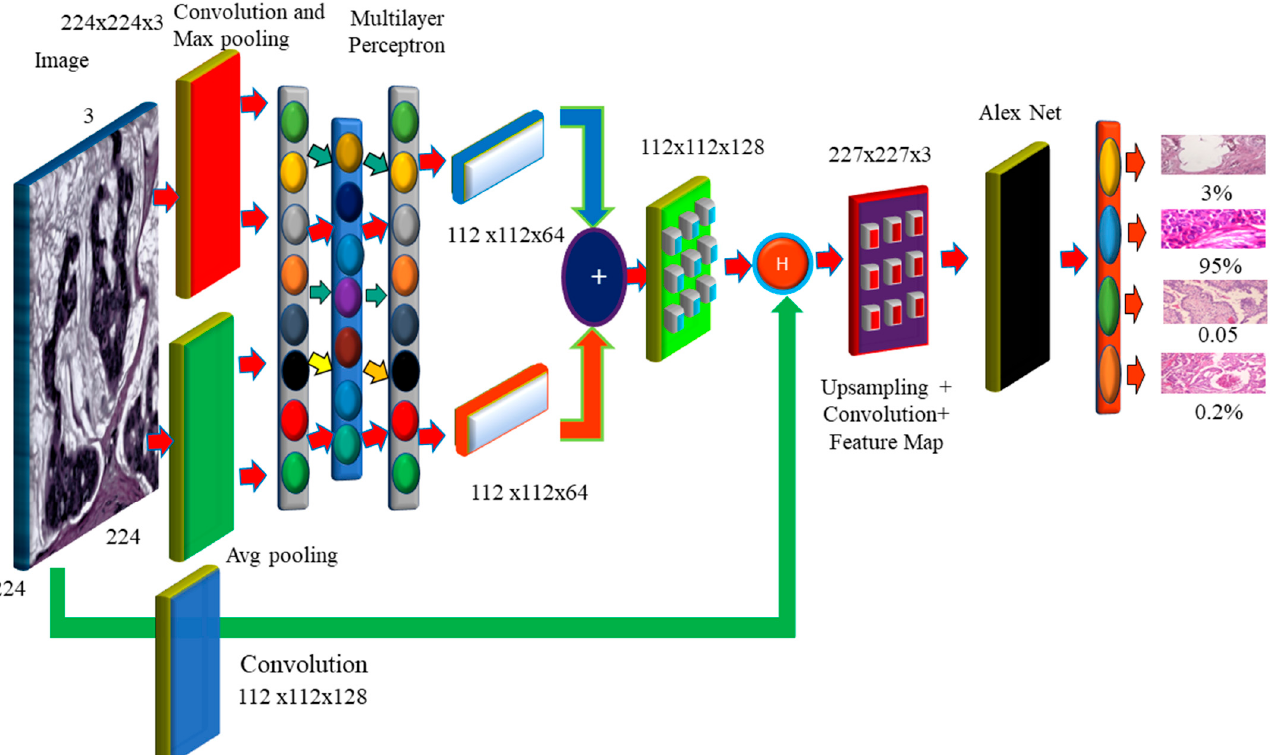
Figure 6. The Proposed Hybrid Dilation Deep Learning Model.